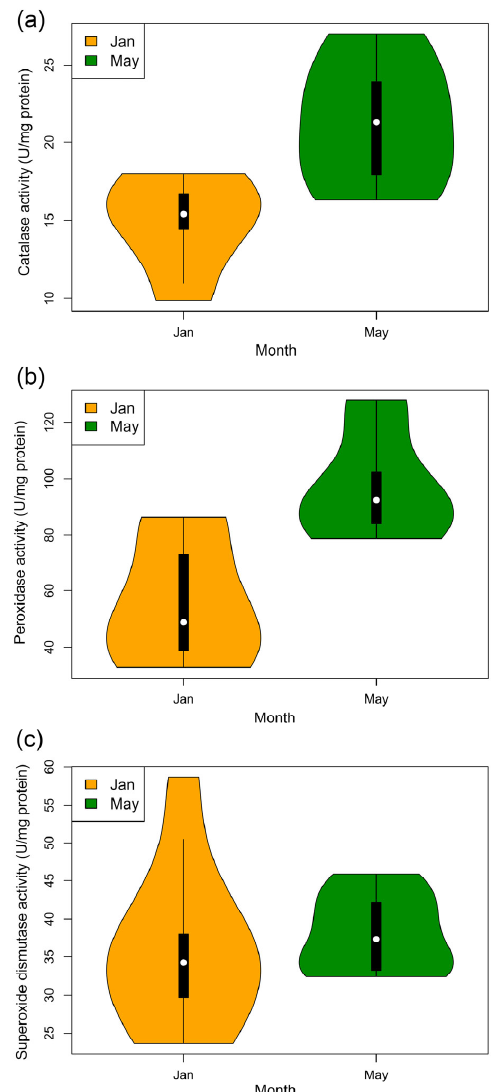
Figure 6. The activities of antioxidant enzymes in D. valens larvae collected in January and May. ( a ) Catalase activity. ( b ) Peroxidase activity. ( c ) Superoxide dismutase